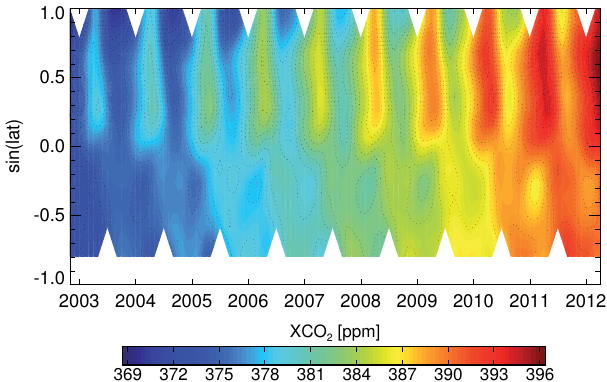
Fig. 2. Overview of the long-term global WFMDv3.6 XCO 2 data set; shown are column-averaged dry air mole fractions as a function of latitude and